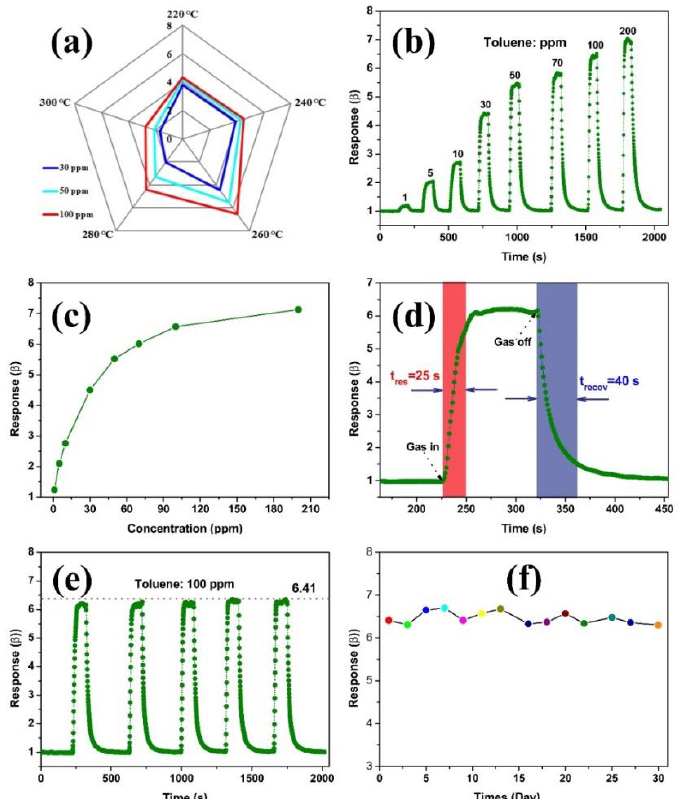
Figure 7. Polar graphs shows the gas responses of gas sensors based on NiFe 2 O 4 nano-octahedrons as 30, 50, and 100 ppm toluene vs. operating temperatures from 220–300 ◦ C ( a ). Dynamic sensing plot of sensors based on NiFe 2 O 4 nano-octahedrons upon exposure to toluene ( b ). Concentration dependent response curve vs. the toluene concentrations (1–200 ppm) ( c ). Response / recovery graph to 100 ppm toluene ( d ), and reproducibility of sensor upon exposure (five cycles) to 100 ppm toluene at 260 ◦ C ( e ). Long-term stability (30 days) of sensor to 100 ppm toluene ( f ).